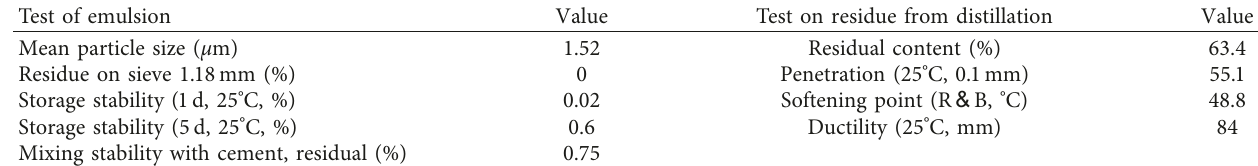
Table 1: Properties of asphalt emulsion.